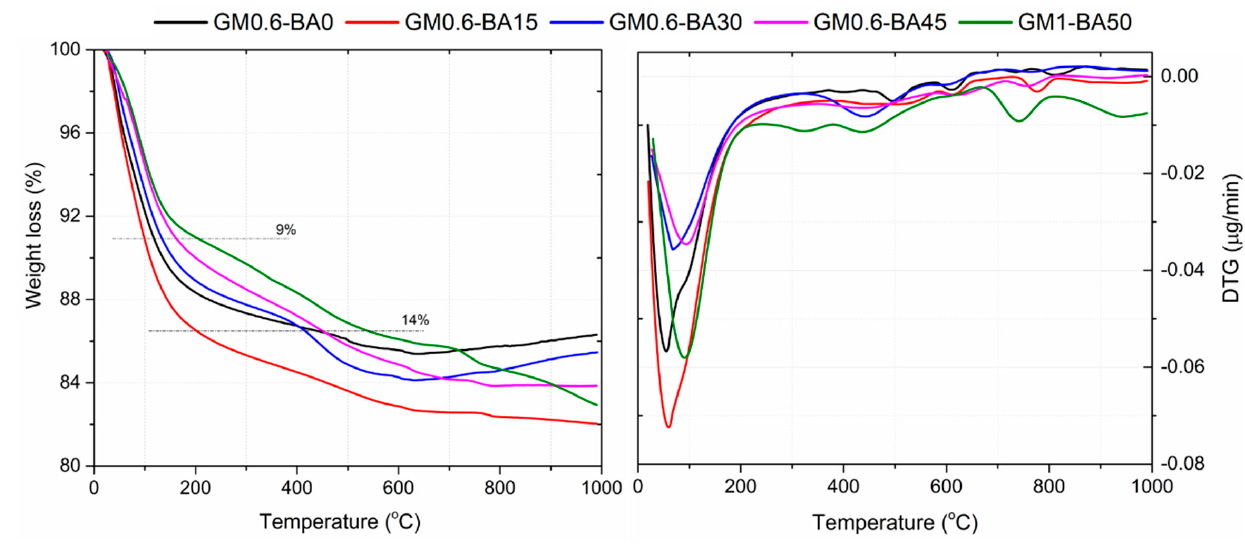
Figure 7. Thermogravimetric analysis of AA paste samples at 91 days.